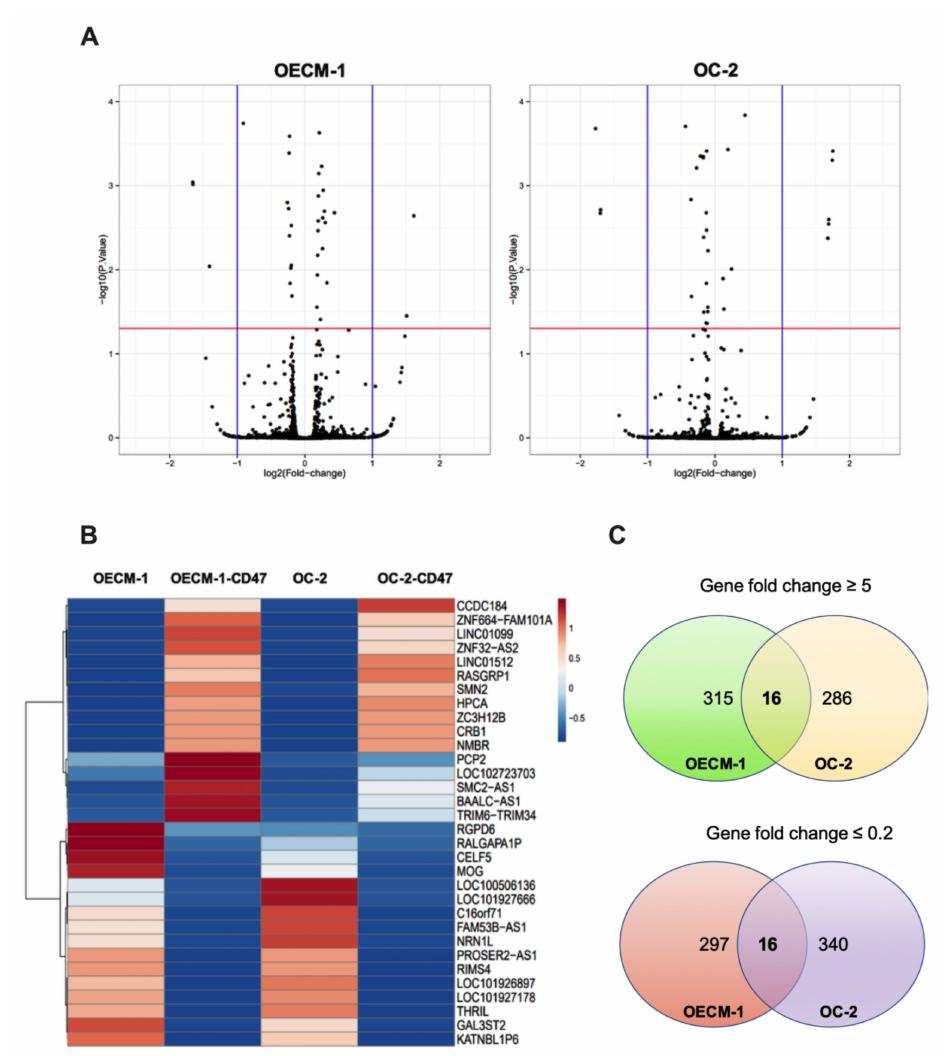
Figure 2. Fold changes in mRNA expression in CD47-overexpressing oral cancer cells. ( A ) A volcano plot showing the differentially upregulated (right panel) and downregulated (left panel) genes in CD47-overexpressing OECM-1 and OC-2 cell lines. ( B ) Heatmap visualization of the RNA sequencing analysis results showing differentially expressed genes with-log10 ( p value) and ≥ 5-fold and ≤ 0.2- fold changes. ( C ) Venn diagram of genes shows that 617 genes were upregulated and 653 genes were downregulated due to CD47-overexpression in oral